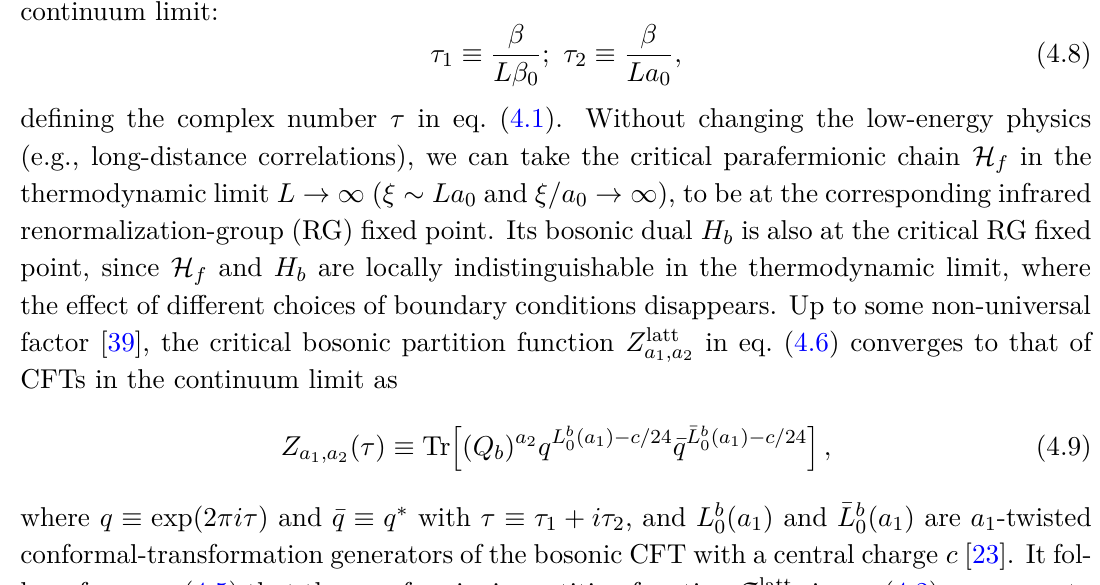
Figure 1 . The visualization of the partition function Z s ( τ 1 , τ 2 ) and the state | Ψ i is summed over. The solid arrow denotes the s 1 -twisted link between γ 2 L and γ 1 which is effectively moved by V transl during the time evolution. The temporal twisting Q s 2 +1 is not explicitly shown in this figure. Here we have included γ 2 j − 1 and γ 2 j into one unit cell thereby denoted by γ 2 j − 1 , 2 j for the sake of